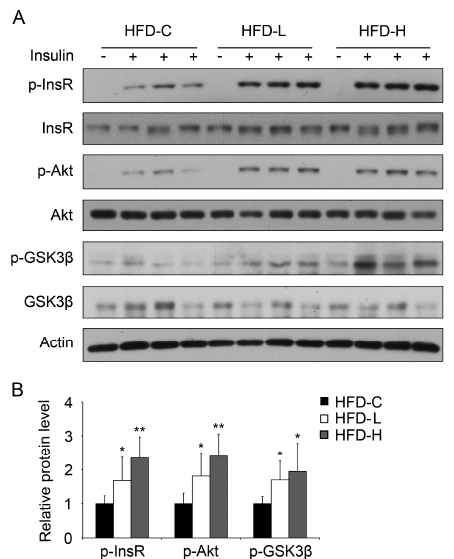
Figure 4. Hemin treatment improves insulin signaling in the liver of HFD mice. ( A ) Mice were fed HFD (HFD-C) or HFD supplemented with hemin at a low (HFD-L) or high dose (HFD-H) for 8 weeks. After fasting for 16 h, mice were injected with or without insulin for 15 min. Subsequently, liver samples were collected for western blot; ( B ) Quantification of p-InsR, p-Akt and p-Gsk3 β protein levels in ( A ). * p < 0.05; ** p < 0.01. n = 6 for each group.